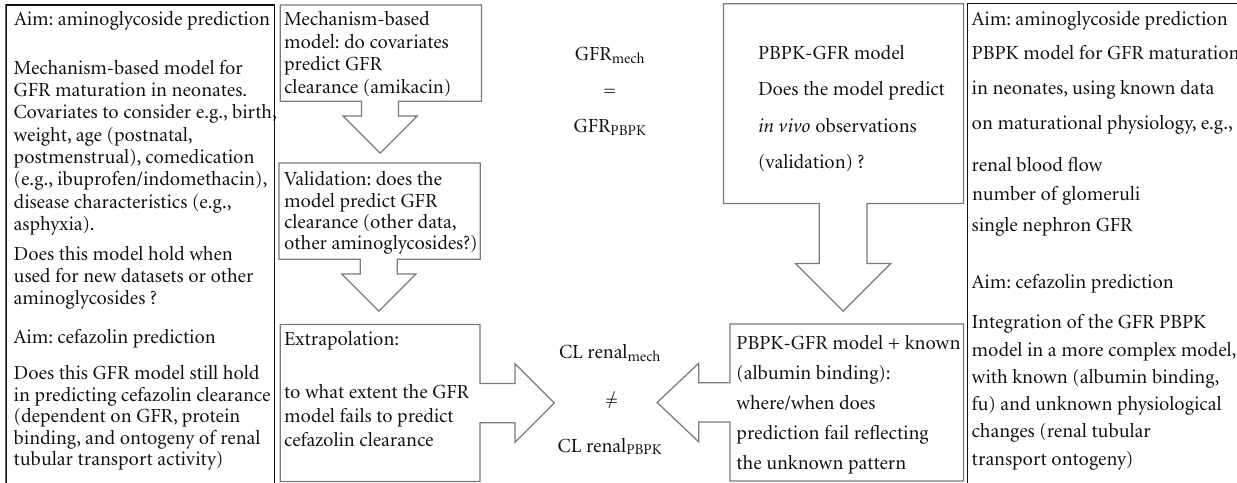
Figure 1: Integration of in vivo datasets analyzed by mechanism-based and PBPK predictive models results in a switch from “explorative, hypothesis-driven” to “confirmative” approach in the field of developmental physiology. This is illustrated for renal drug clearance in neonates, which reflects glomerular filtration rate (e.g., aminoglycosides) or a more complex pattern of known (glomerular filtration rate, protein binding) and still unknown (renal tubular transport ontogeny) (e.g., cefazolin) maturational